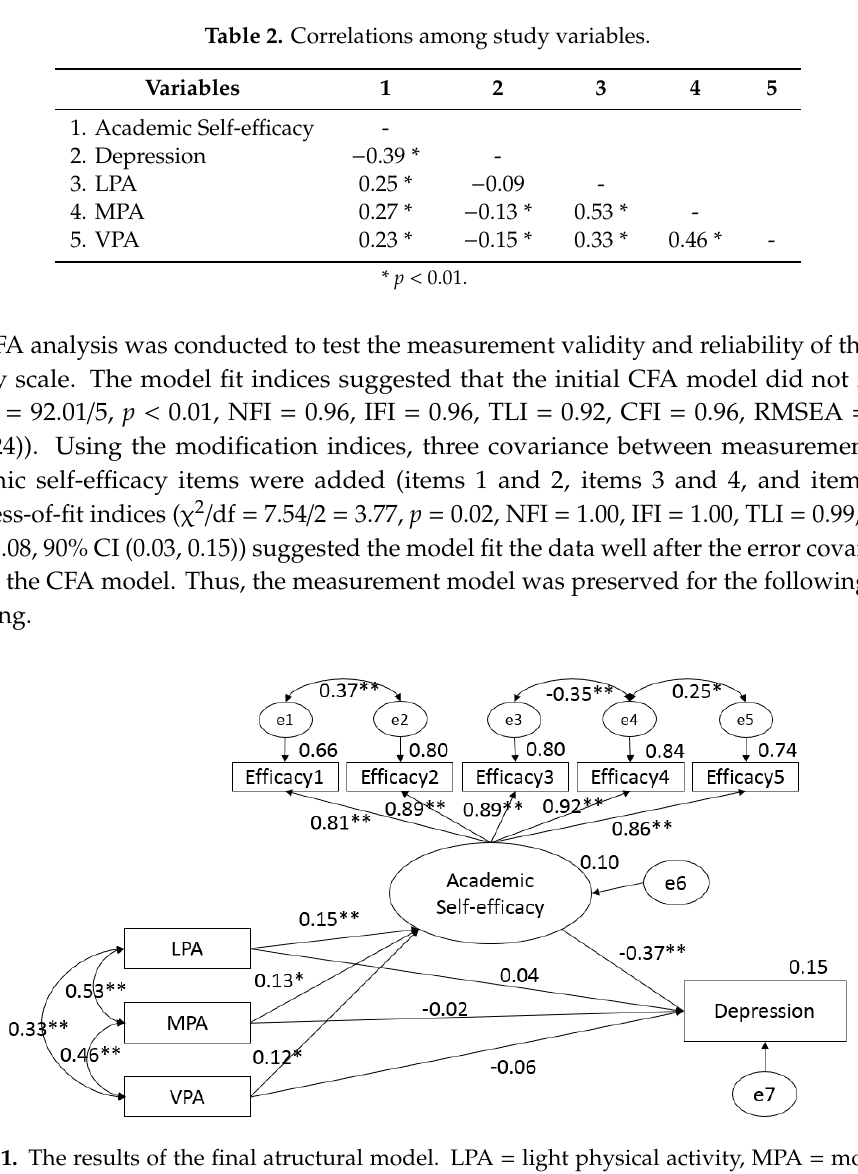
Figure 1. The results of the final structural model. LPA = light physical activity, MPA = moderate